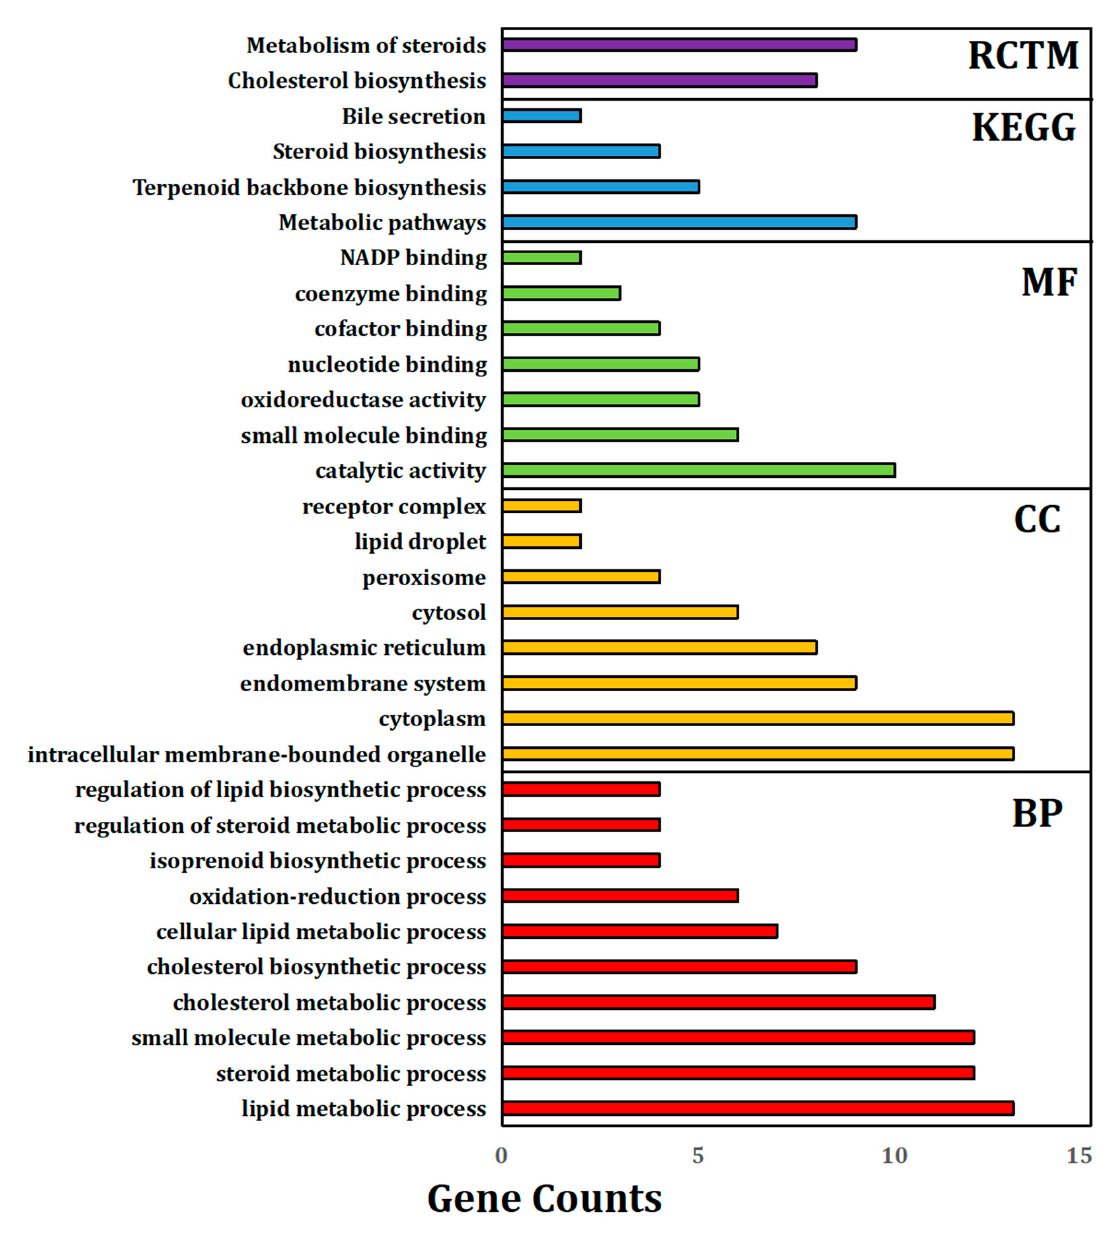
Figure 7. Histogram showing the pivotal genes enriched in GO, KEGG, and Reactome pathways. BP: biological process; CC: cellular component; MF: molecular function; KEGG: Kyoto encyclopedia of genes and genomes pathway; RCTM: Reactome protein.